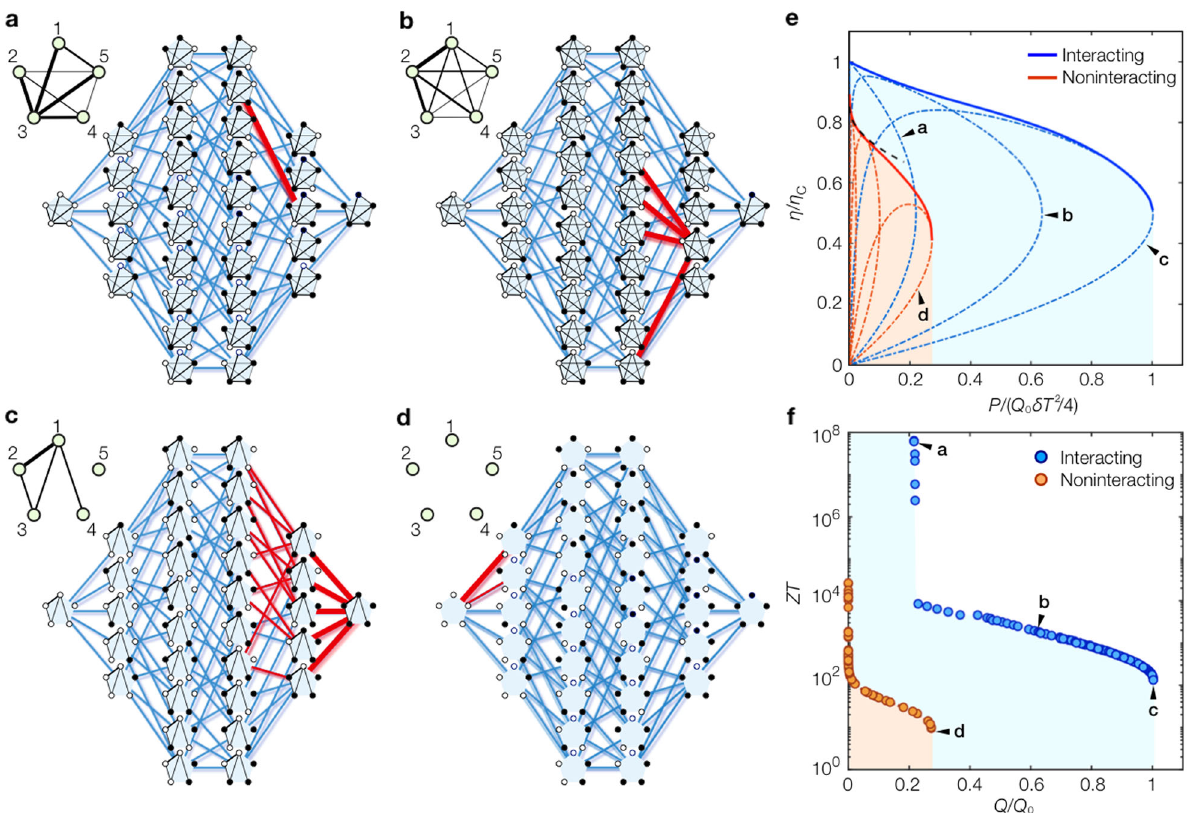
Fig. 2 Learning network topologies of the best nanoscale heat engines. a – d Topologies of the interaction networks (insets) and the state-transfer networks (main panels) for the Pareto-optimal heat engines indicated by labels ( a – d ) in e , f . They attain a the highest ZT , b the suboptimal ZT and Q , c the highest Q , and d the highest Q in the noninteracting case. The red edges in the state-transfer networks indicate the activated transfer edges along which the probability fl ow is signi fi cant. In c , the highest power is achieved by the sparse interaction network, where degenerate weakly interacting holes result in the maximal activation of transfer edges. In a and b , the strong and dense interactions isolate several states from the other ones and solely activate transfer edges within those isolated manifolds. The thickness of links in the insets represents the strength of interaction. e , f The obtained best trade-offs between e power P and ef fi ciency η , and f power factor Q and fi gure of merit ZT . The blue (red) shaded region is allowed for interacting (noninteracting) heat engines and its upper boundary indicated by solid curves represents the Pareto front, i.e., the set of the optimal machines for which two objectives cannot be further improved without compromising the other. The dashed curves correspond to the power-ef fi ciency curves for each Pareto-optimal machine. The black ffiffiffi p P dashed curve in e indicates the scaling 1 (cid:2) η = η / at low power in the noninteracting case (see the fi gures in “ Methods ” ). We set N f = 5, ϵ l = l Δ with C T = 3, γ = γ ≡ γ and plot Q in the unit of Q = k γ / T . The ef fi ciency and power factor are normalized by η Δ / k B h c 0 B